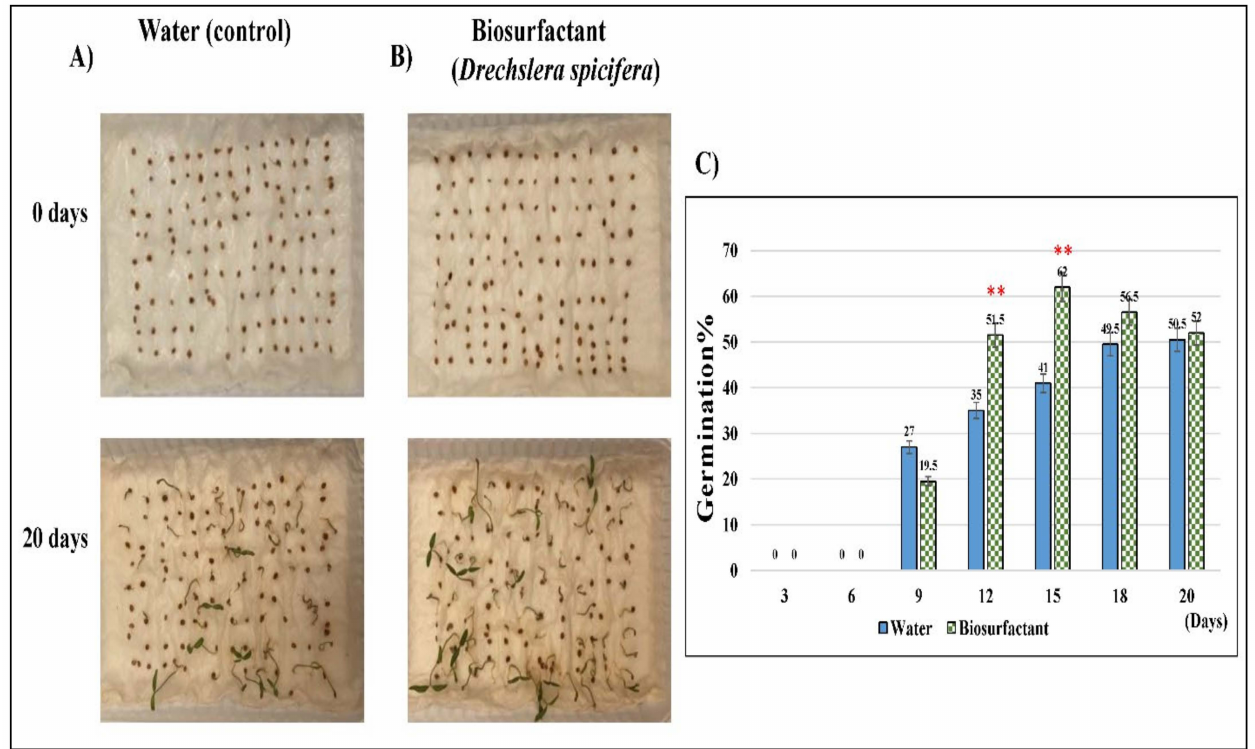
Figure 6. Germination assay of D. spicifera. Assessment of toxicity of bio-surfactants produced by D. spicifera on the germination of 100 tomato seed for 20 days. ( A ) Untreated seeds (water as control), ( B ) seeds treated with CFS of D. spicifera , ( C ) percentage of germination for 20 days. ** indicates significant p <